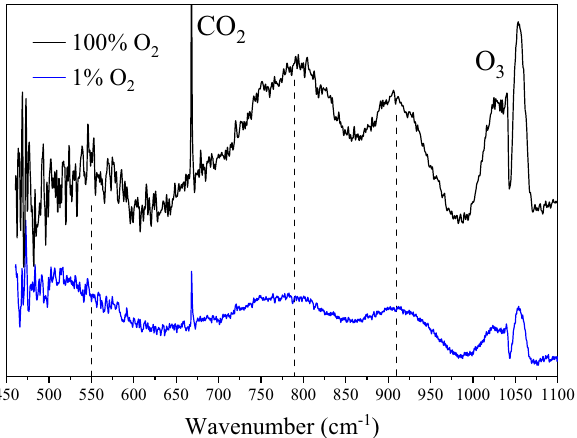
Figure 4. In-situ FTIR spectra of collected particulates after ablation of uranium in 100% O 2 (black) and 1% O 2 (blue). Formation of am-UO x (3 ≤ x ≤ 4), indicated by the two uranyl stretching modes (790 and 910 cm −1 ), is observed in both high and low oxygen environments. Additional spectral intensity below 550 cm −1 suggests a different uranium oxide, assigned to UO 2 , is also formed in 1% O 2 atmospheres. Spectra are offset for clarity.